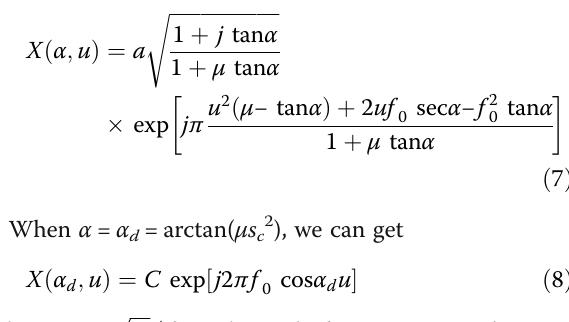
ffiffiffiffiffiffiffiffiffiffiffiffiffiffiffiffiffiffiffiffiffiffiffi 1 þ j tan α d d